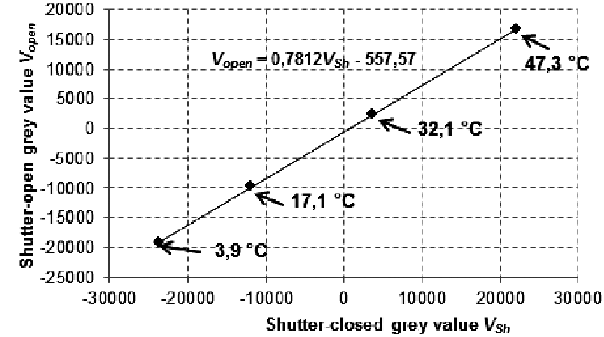
Figure 13. Shutter characteristic curve. Parameter: camera temper- ature of the respective measurement points.